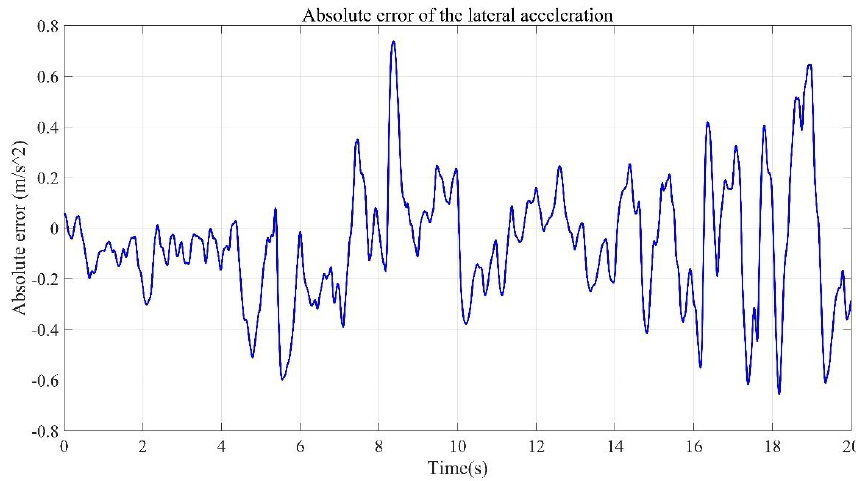
Figure 20. Absolute error of the lateral acceleration between the vehicle dynamics model using estimation results and the real vehicle test.